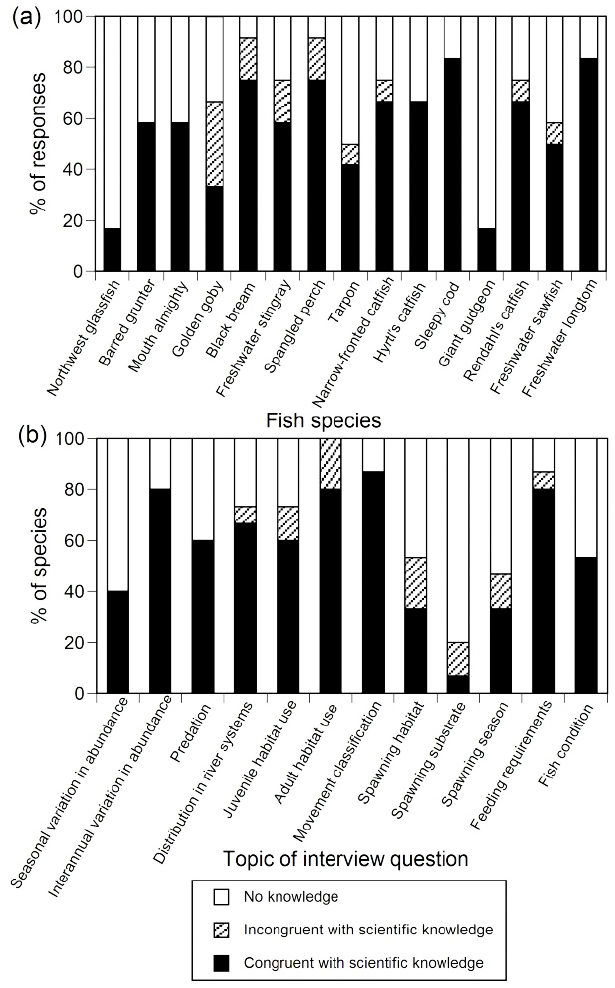
Fig. 3 . Summary of indigenous ecological knowledge by (a) fish species and (b) topic of interview questions relevant to environmental flow assessments of fish in the Daly